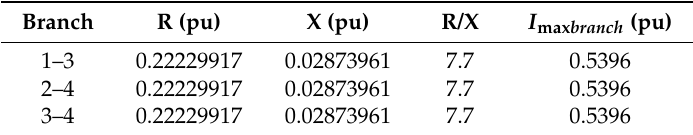
Table 2. Electric parameters of the microgrid